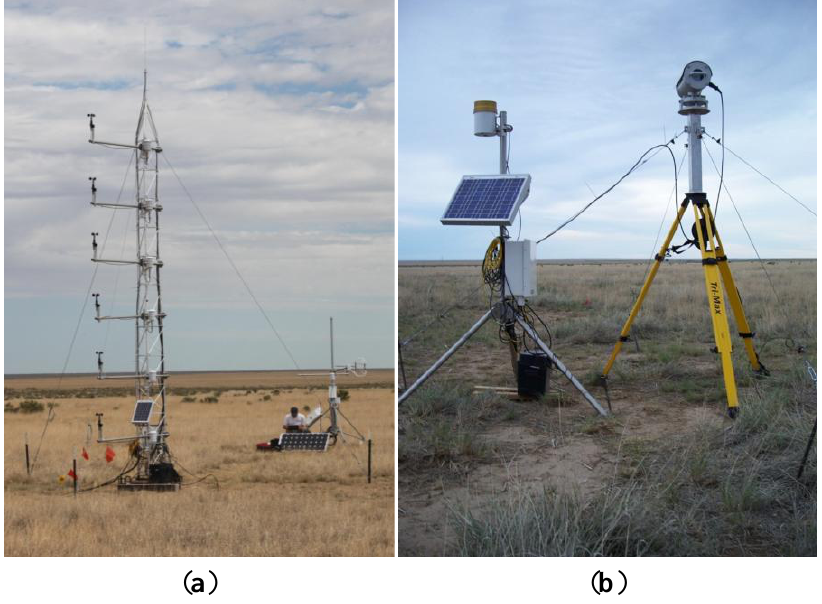
Figure 2. Photos of SAT and EC tower setup ( a ) and LAS-1 Receiver (LAS1R, Figure 1) setup ( b ). Left photo was taken on 21 July 2011 and right photo was taken on 3 August